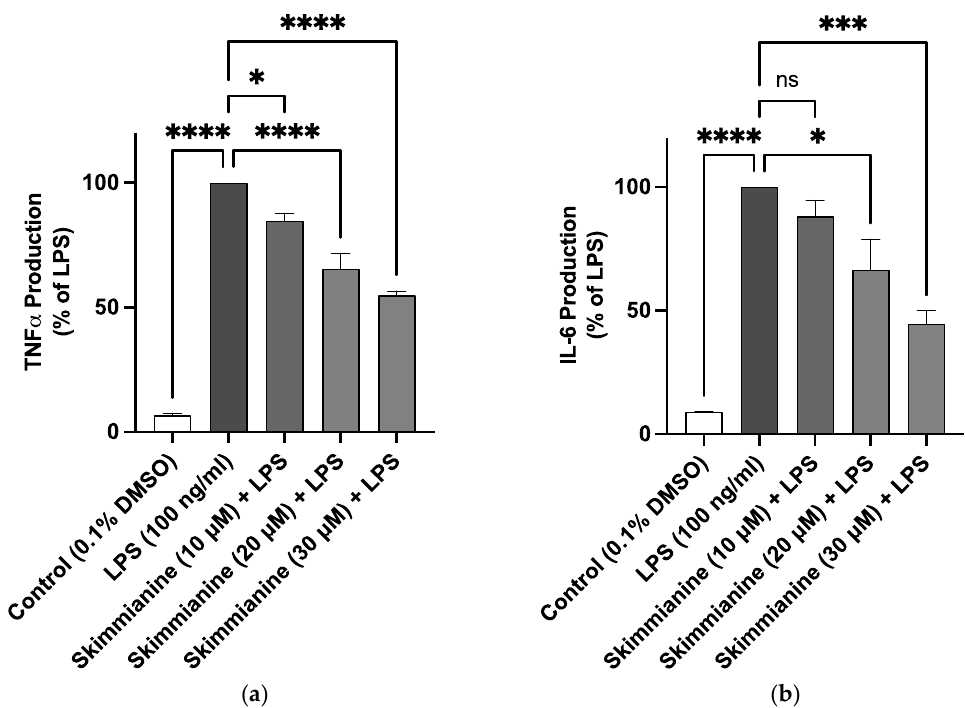
Figure 3. Skimmianine decreased TNF α and IL-6 production in BV-2 microglia cells stimulated with LPS. BV-2 cells were treated with or without skimmianine (10, 20 and 30 μ M) and then stimulated with LPS (100 ng/mL) for 24 h. TNF α ( a ) and IL-6 ( b ) levels in cell culture supernatants were analysed using mouse ELISA kits. Values are mean ± SEM of at least three independent experiments. A statistical analysis was carried out using a one-way ANOVA with a post hoc Dunnett’s test. ns (not significant at p < 0.05); * p < 0.05; *** p < 0.001, **** p < 0.0001 in comparison with LPS stimulation.